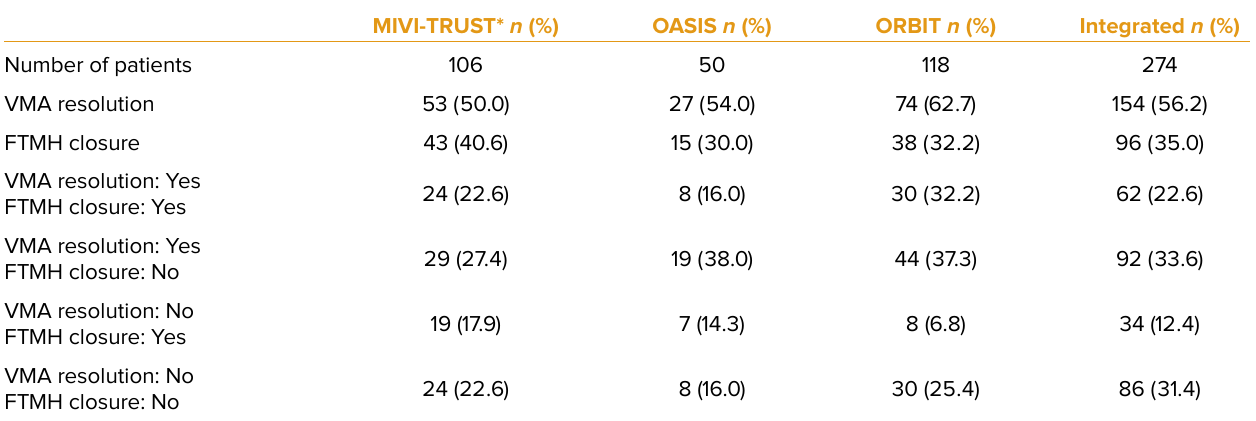
Table 2. Rates of VMA resolution and FTMH closure in the four studies and the integrated dataset MIVI-TRUST* n (%)